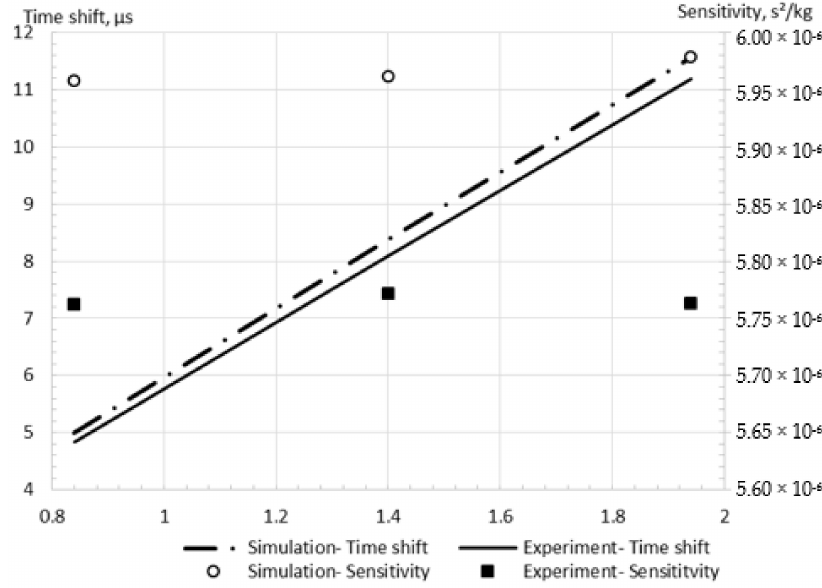
Figure 13. Simulation results in comparison with experimental data by Hu et al.